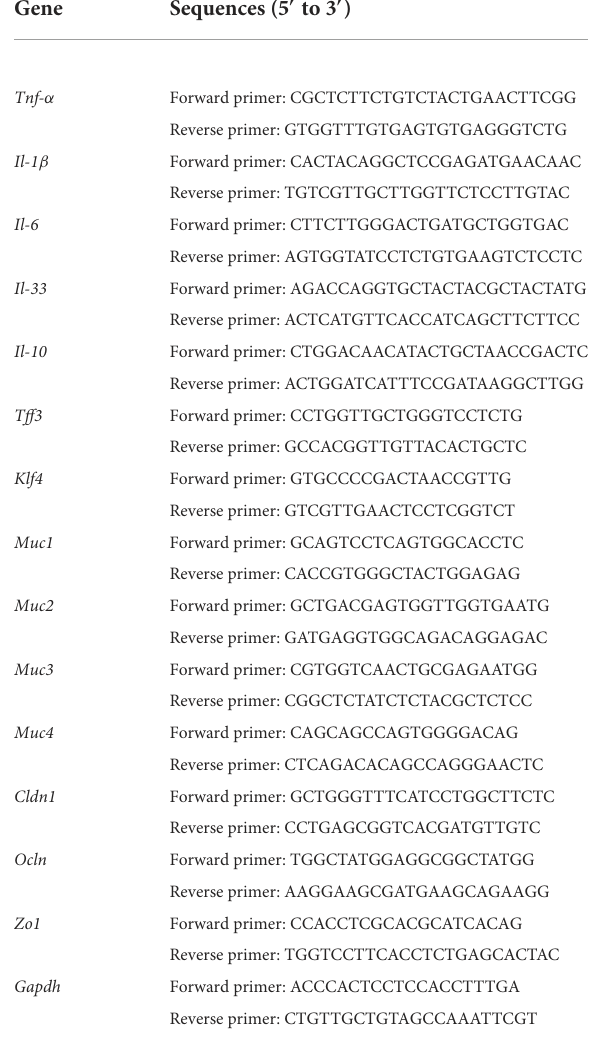
TABLE 1 Primer design of qPCR.